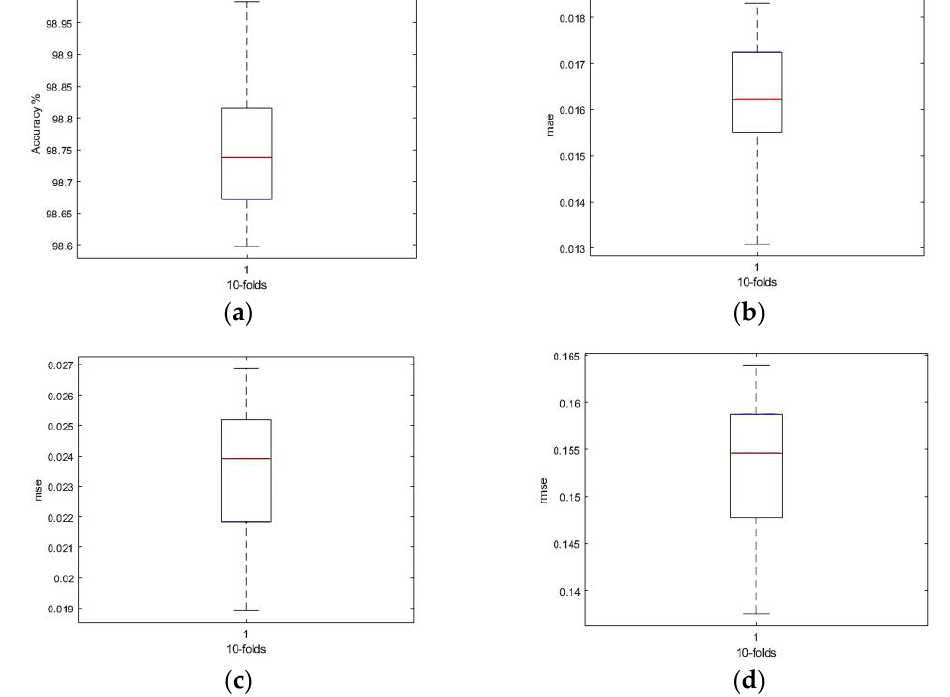
Figure 5. 3SFNN of falling precision with the 10-cross valuation (no optimization): ( a ) accuracy; ( b ) MAE; ( c ) MSE; ( d ) RMSE.